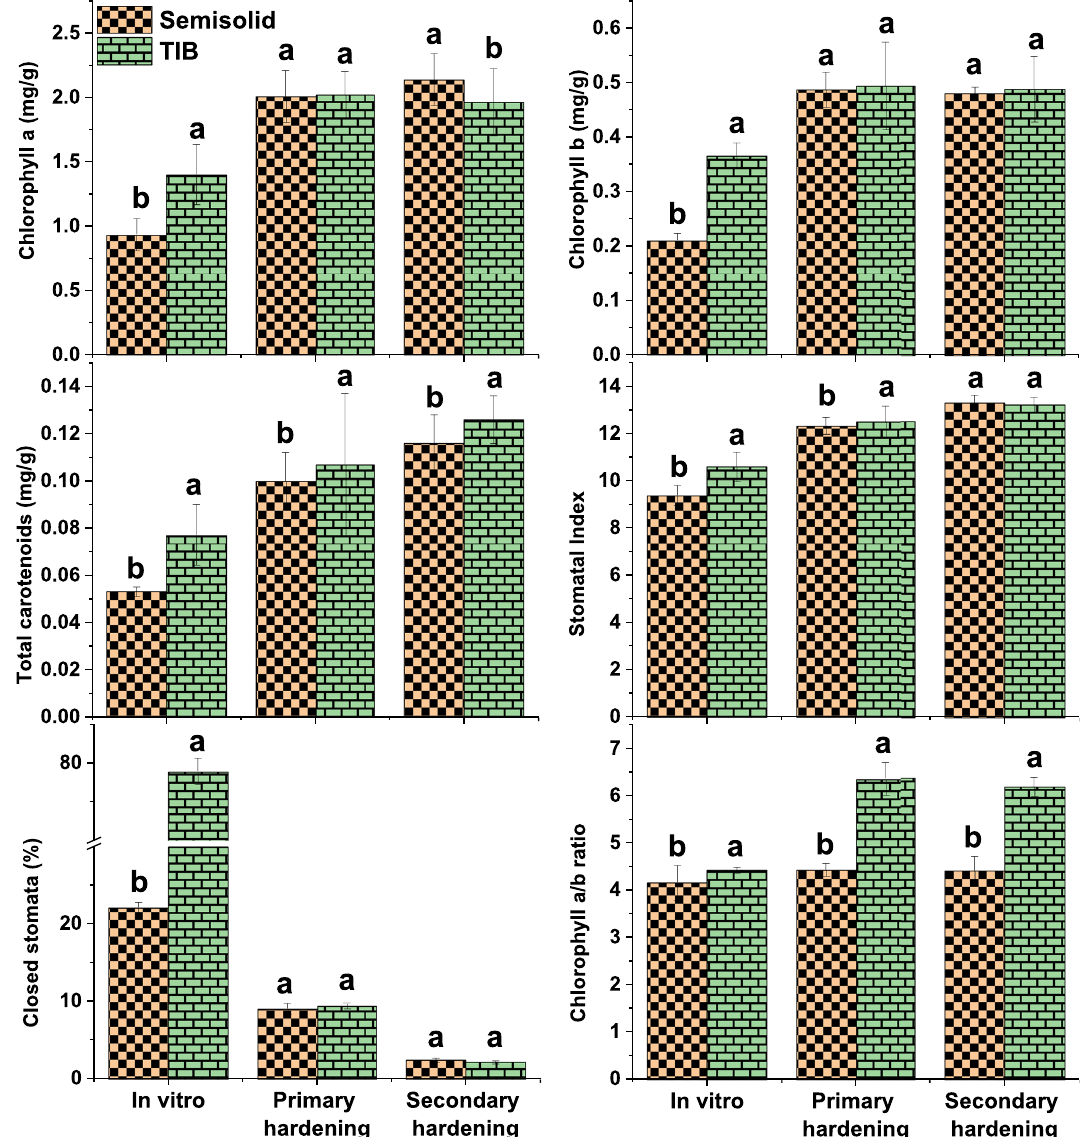
Figure 5. Change in chlorophyll a, b and ratio, carotenoid content, stomatal index and number of closed stomata in leaves of banana plantlets during the harvest from in vitro culture, primary and secondary hardening. ( a ) Chlorophyll a, ( b ) Chlorophyll b, ( c ) Chlorophyll a/b ratio, ( d ) Total carotenoid, ( e ) stomatal index, ( f ) Closed stomata (Graphs were generated using OriginLab Professional Version 2021b software; URL link: www. Origi nLab. com/